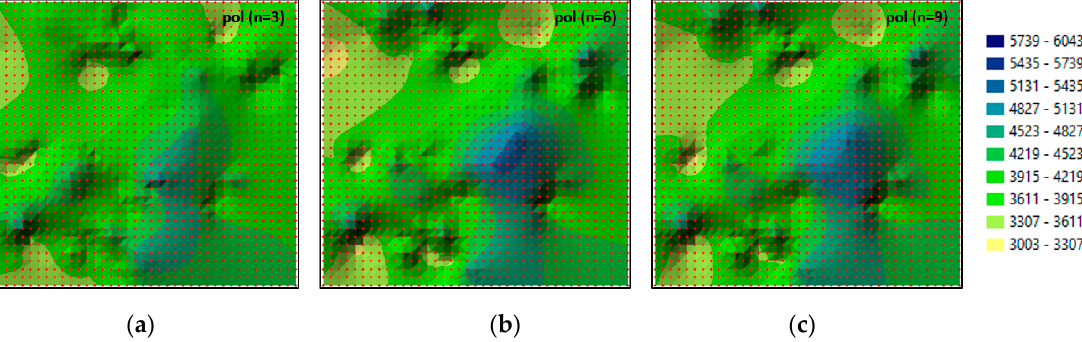
Figure 6. Interpolation surfaces of real estate prices reconstructed for 2012 based on GRID nodes generated for various degrees (n) of polynomials for all measurement epochs; ( a ) 3rd degree polynomial; ( b ) 6th degree polynomial; ( c ) 9th degree polynomial. Source: own elaboration.